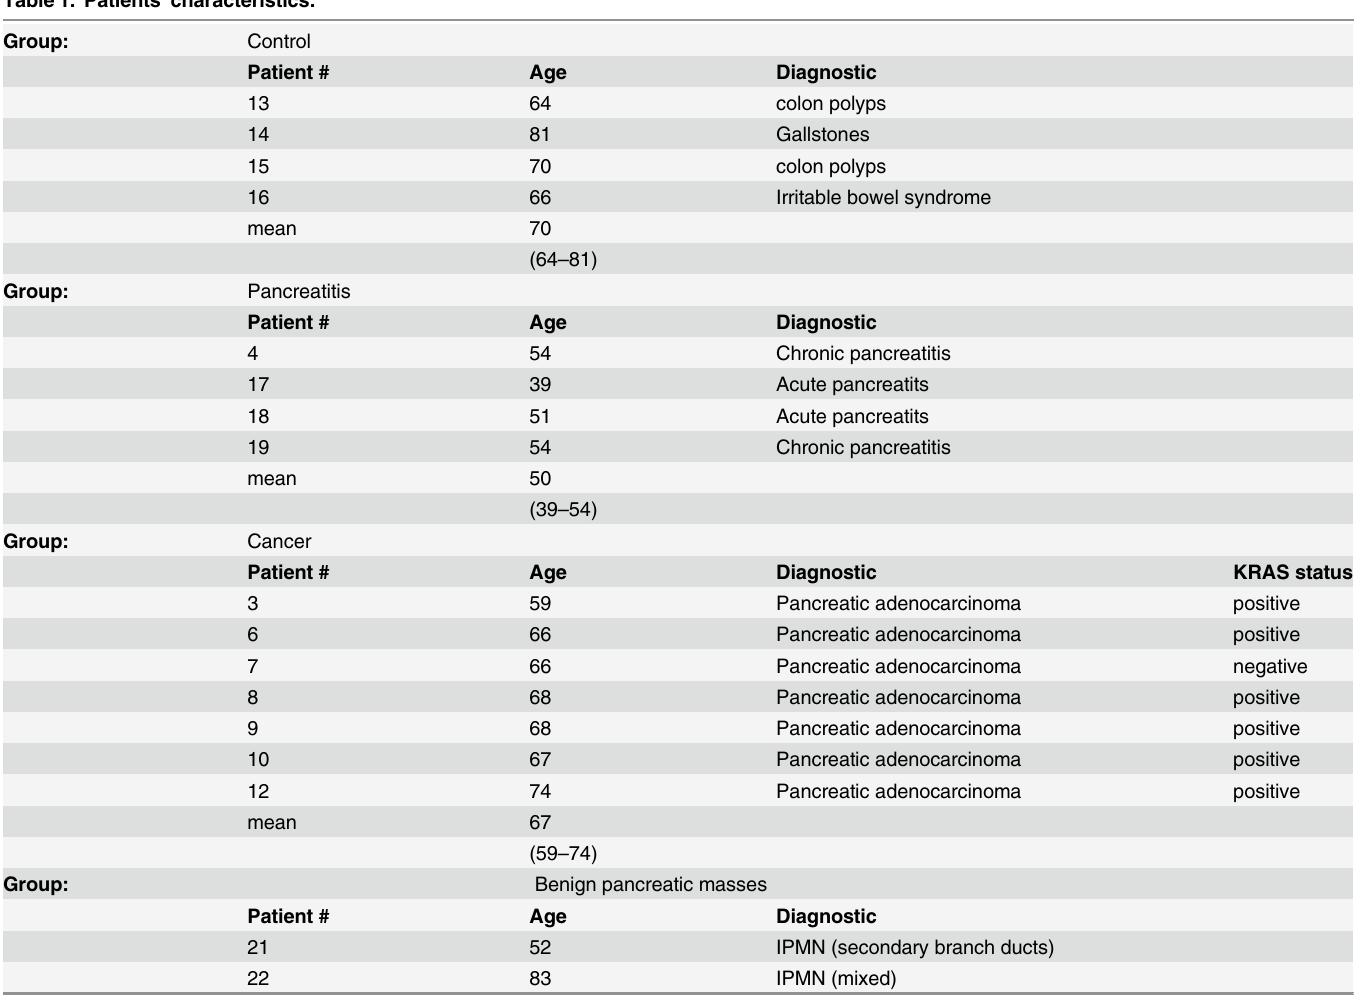
Table 1. Patients ’